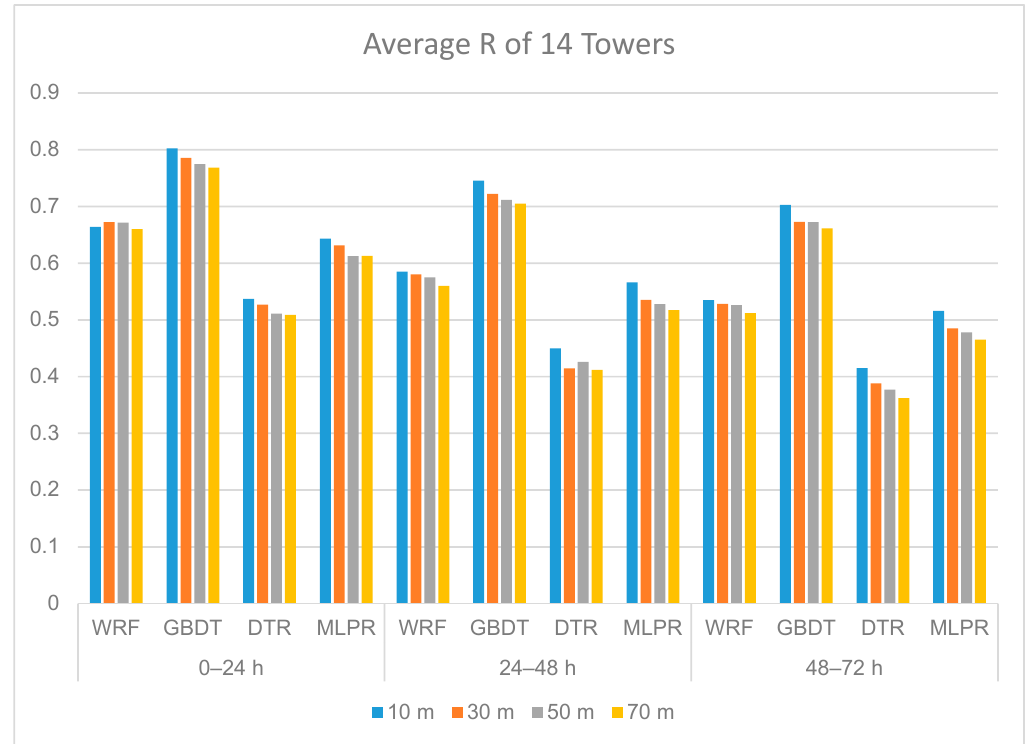
Figure 10. Rs of the WRF original output (WRF), GBDT output (GBDT), decision tree regression output (DTR), and multi-layer perceptron regression output (MLPR).